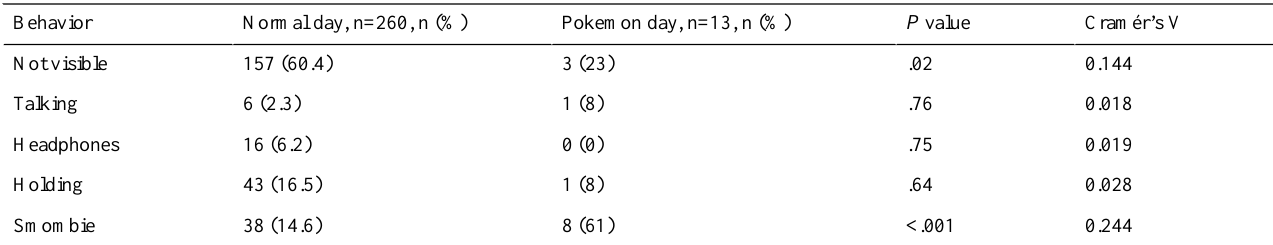
Table 11. Influence of the Pokemon Go Community Day on the smartphone usage behavior in teenagers (globally P <.001,